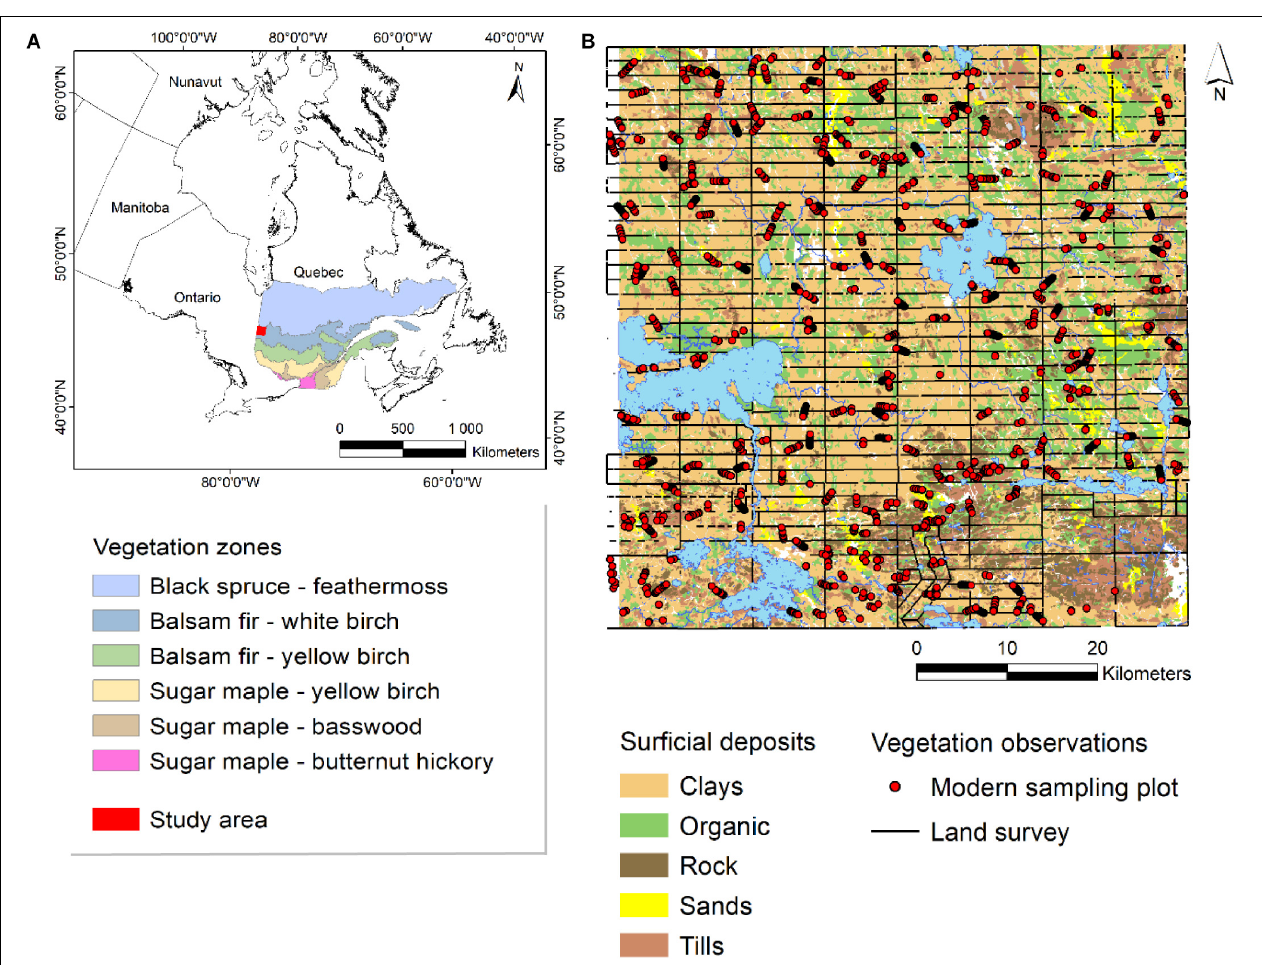
FIGURE 1 | Location of the study area according to the ecological land classification of the Ministère des ressources naturelles du Québec (Saucier et al., 2009) (A) . Study area and distribution of surficial deposits, land survey data and modern sampling plots (B)